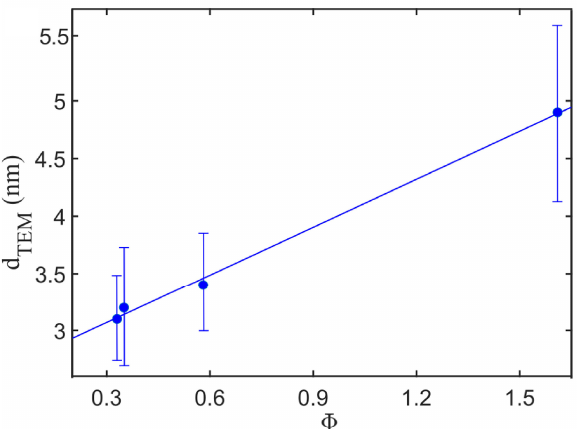
Figure 2. Primary particle sizes of iron-oxide NPs, measured from the micrographs obtained through the application of the transmission electron microscopy (TEM), as a function of the equivalence ratio [12].